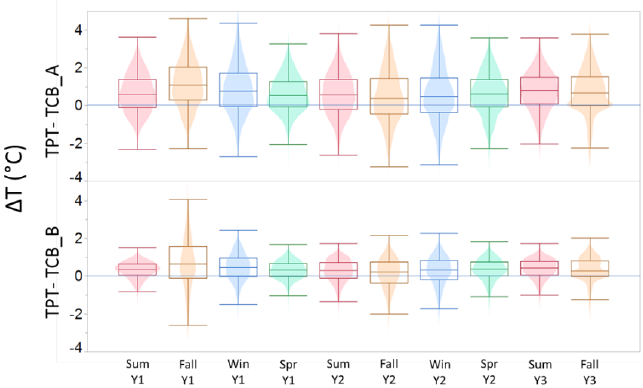
Figure 3. Violin plots representing ∆ T cell (between TPT- TCB_A and TPT-TCB_B) seasonal trends over 10 seasons/two and a half years initiating from summer (Sum Y1) to fall (Fall Y3) in one-cell modules installed at the AZ-1 site.